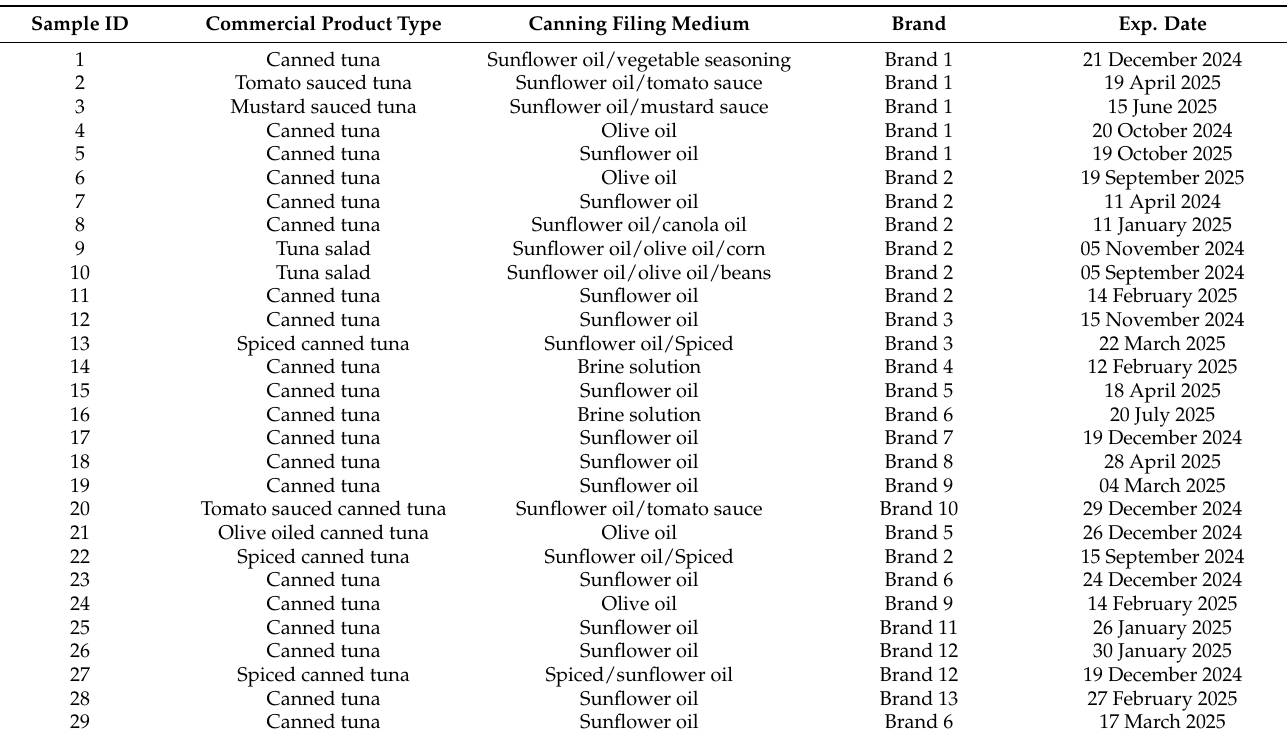
Table 1. Sample descriptions of canned